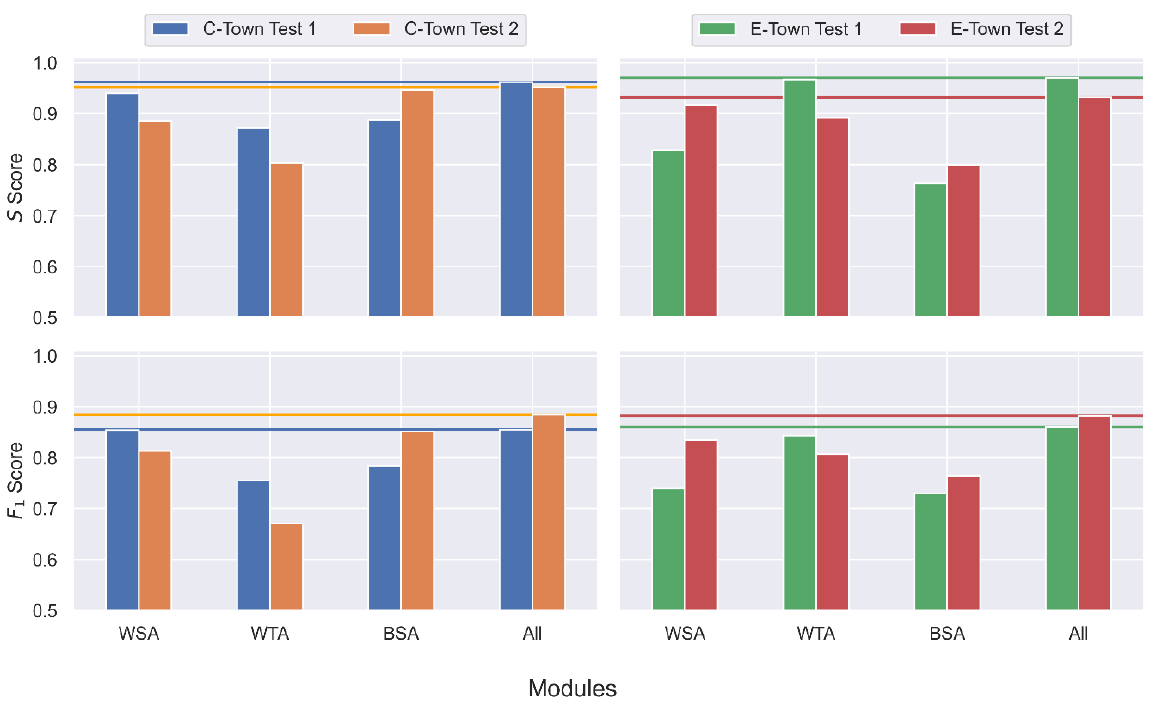
Figure A1. Performance of the SSDS modules. Individual modules (in bars) against all modules combined (in ‘ All ’ bars and horizontal lines).